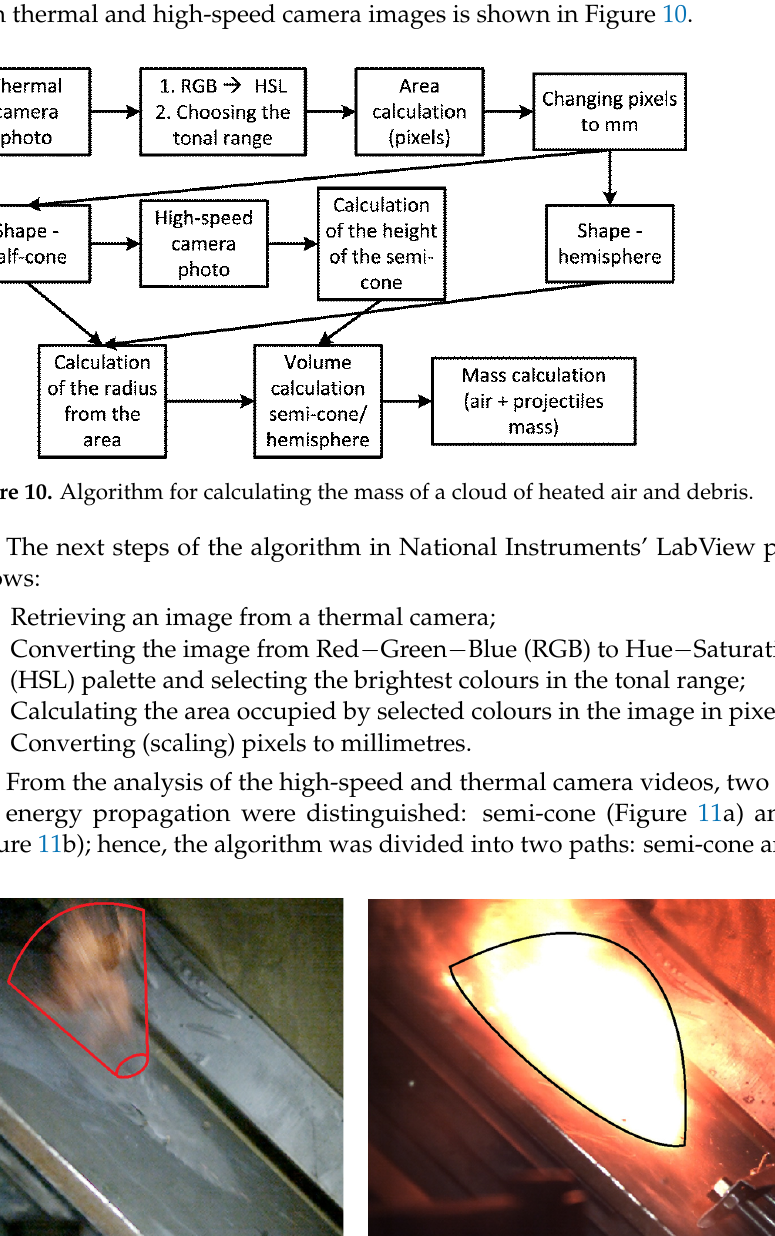
( a ) X6580sc (660 fps); ( b ) A6901scSLS (2615 fps).